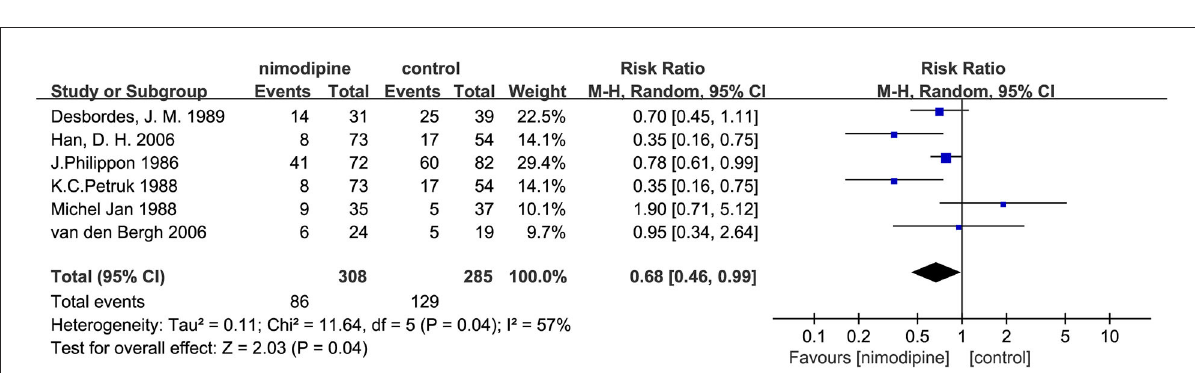
FIGURE9 Efficacy of nimodipine-use in the prevention of cerebral vasospasm in SAH